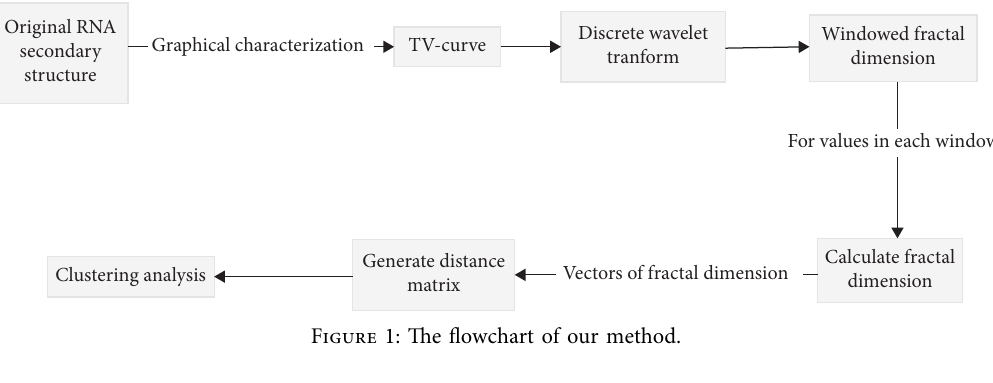
Figure 1: The flowchart of our